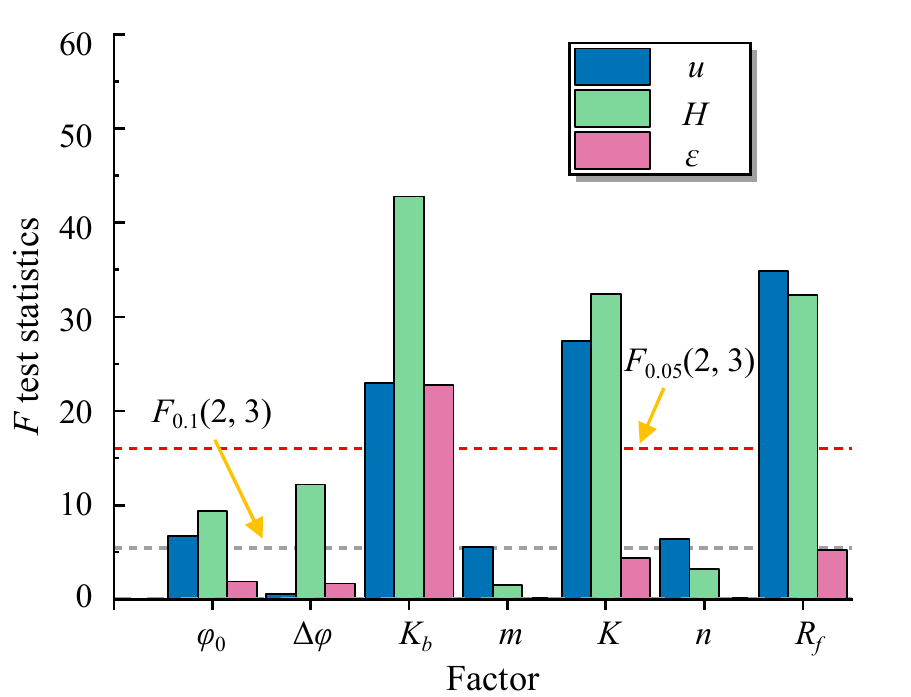
Figure 13. ANOVA results of each parameter in reservoir bottom backfill zone to different indexes.